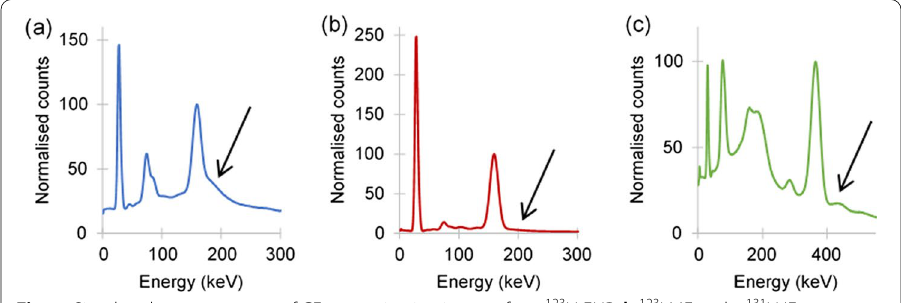
Fig. 4 Simulated energy spectra of CF point projection images for a 123 I LEHR, b 123 I ME and c 131 I